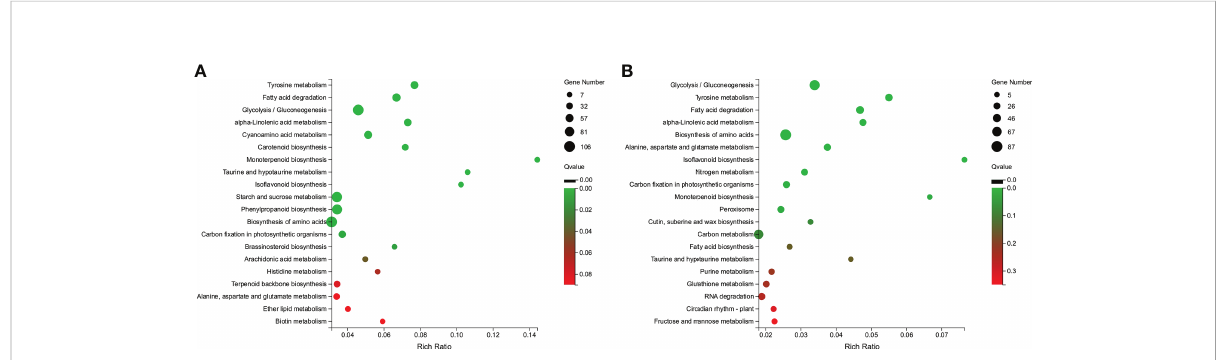
FIGURE 5 KEGG enrichment analysis of DEGs in P. ostii roots. (A) , Waterlogging treatment (CK VS WT); (B) , Waterlogging recovery treatment (WT VS